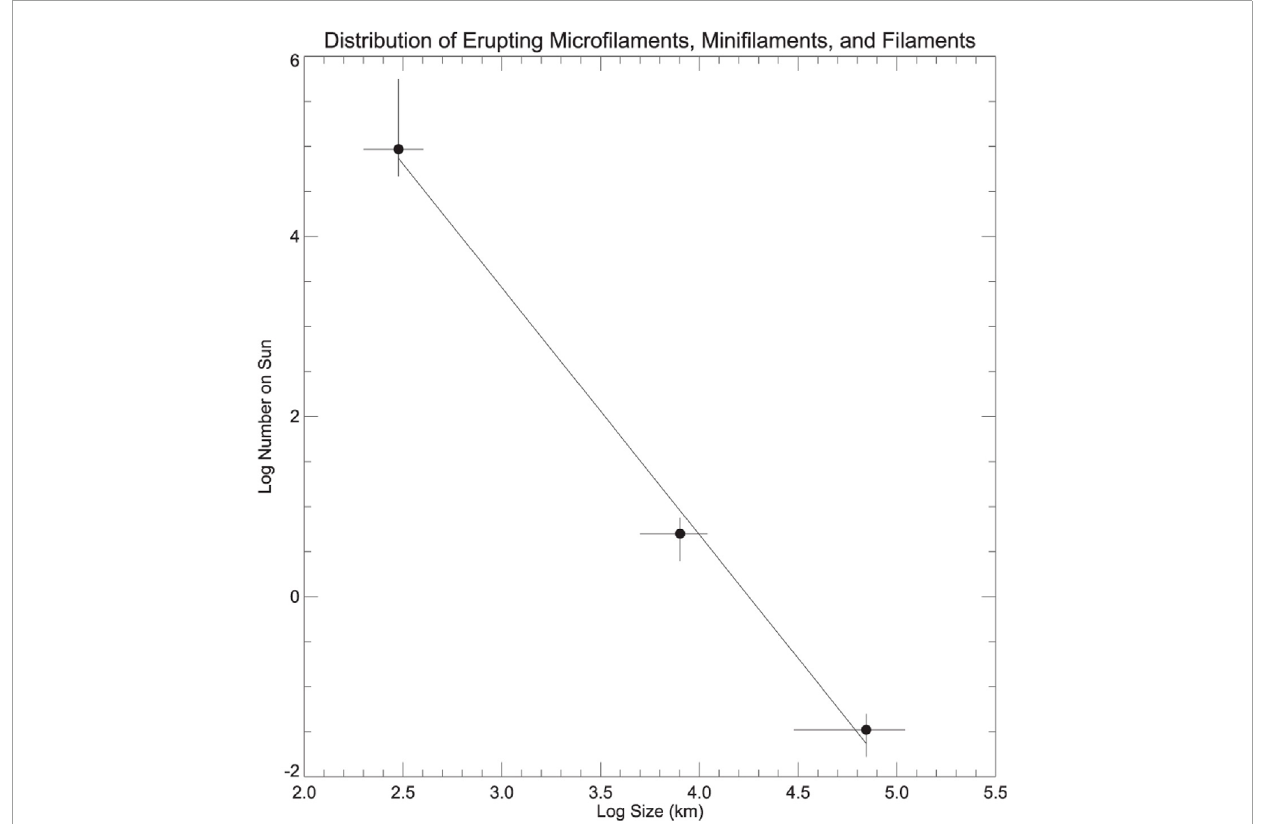
FIGURE 5 Plot showing the instantaneous number distribution of filament-like eruptive events on the Sun, where those eruptions plausibly all operate by the same general eruptive mechanism as that for coronal jets pictured in Figure 2 . The horizontal axis is the size of the erupting cool-material feature, and the vertical axis shows an estimate of the number of eruptions of those features occurring on the Sun at any given time. There are only three points plotted. The right-most point represents large-scale eruptions of typical-sized filaments that produce solar flares, and CMEs in the case of ejective eruptions. The middle point represents coronal jets, such as shown in Figures 1 , 3 , and which are made by minifilament eruptions as depicted in Figure 2 . The leftmost point is for speculative “erupting microfilaments” (erupting microfilament-carrying flux ropes) of the size scale of spicules, and which might produce spicules or spicule-like features in the manner of Figure 2 . “Error” bars represent uncertainties in the observational parameters. This plot demonstrates the plausibility that spicules might fit on the same power-law distribution as large-scale eruptions and the minifilament eruptions that make jets, but much more evidence is required before a firm conclusion can be make regarding whether some or most spicules are generated in a manner analogous to how coronal jets are made. This plot is from Sterling and Moore (2016); see that paper for further